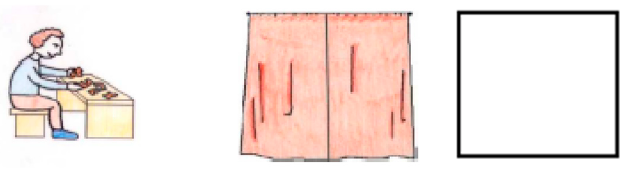
Figure 1. Story book page of an item in the narrative setting.